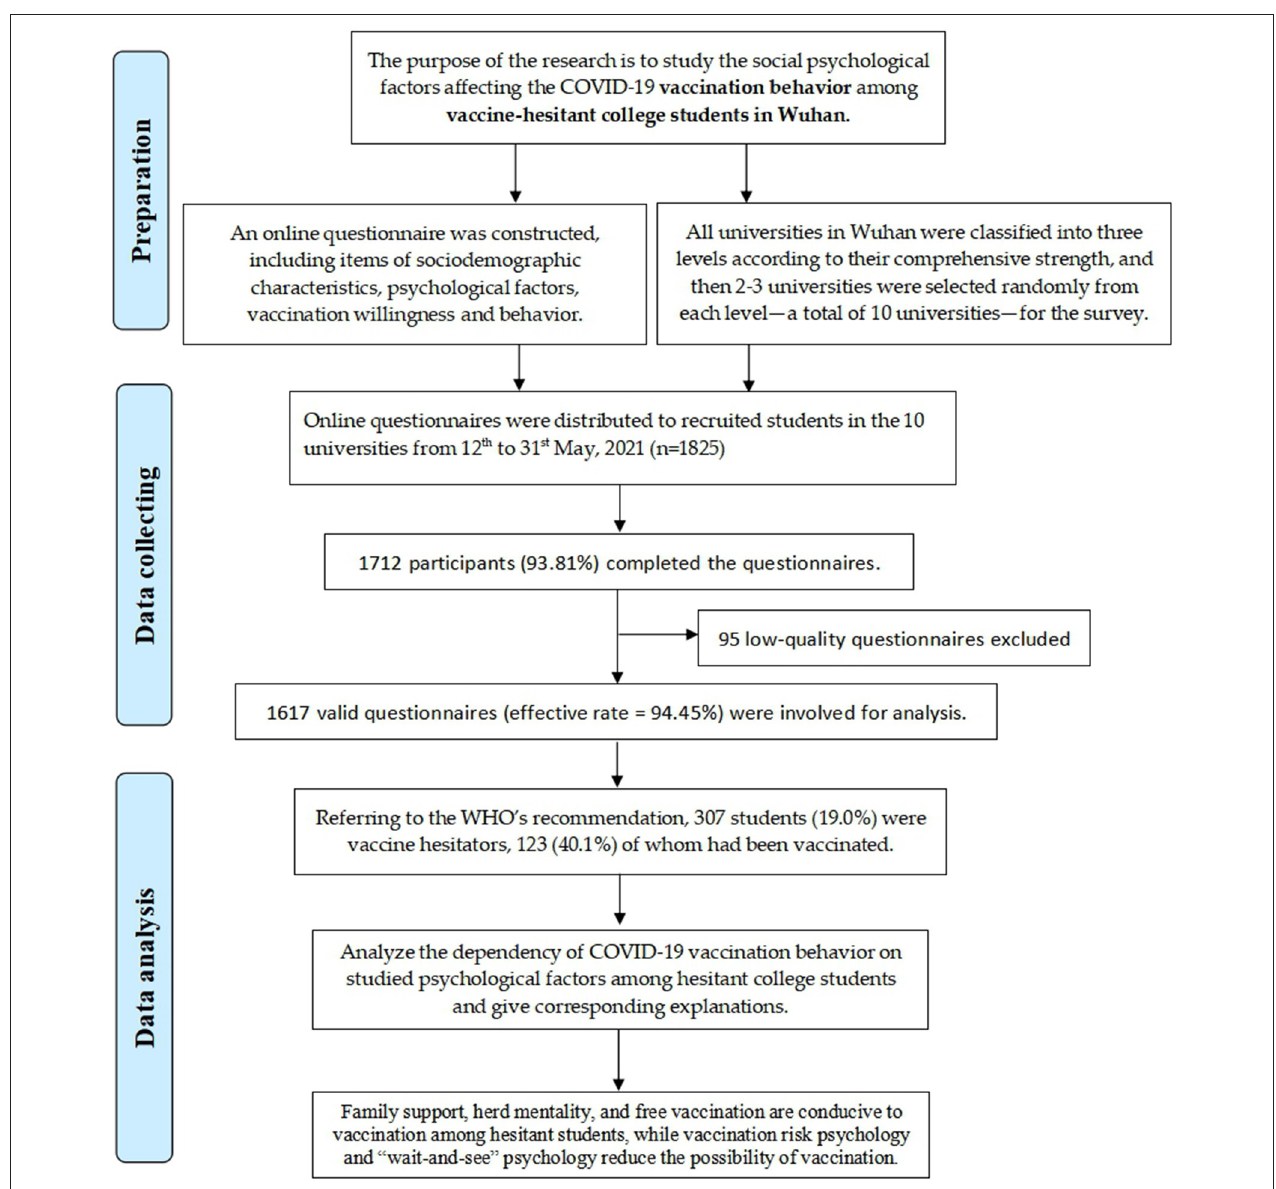
FIGURE 1 | Flow diagram for the study